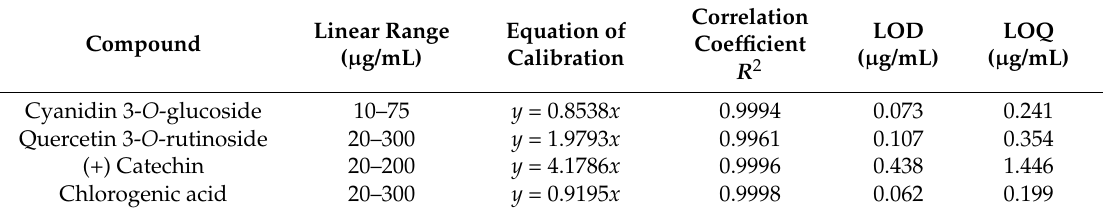
Table 8. Analytical characteristics for determination of phenolic